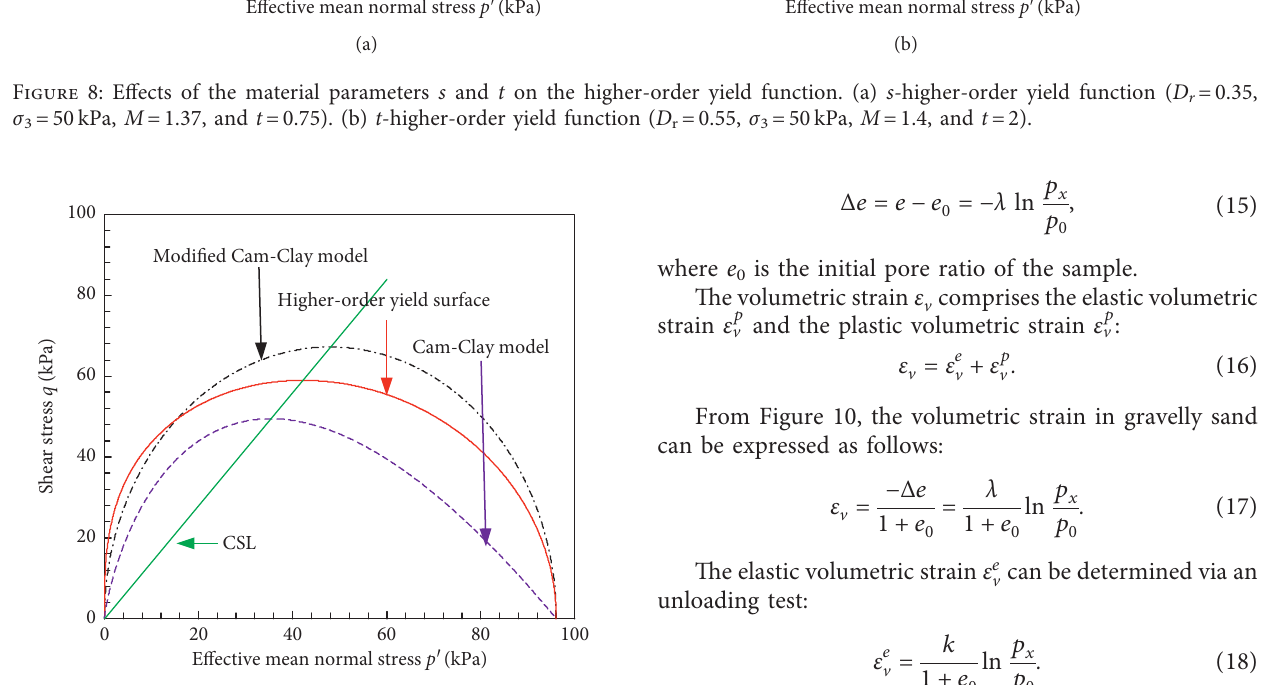
Figure 9: Yield surface locus in the p - q coordinate system.